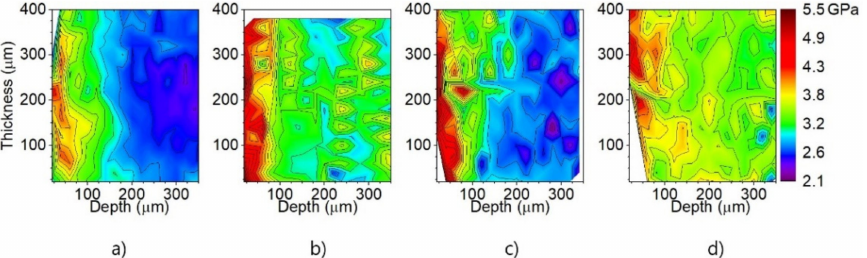
Figure 8. Maps of hardness obtained by means of nanoindentation measurements near the cutting edge before annealing of rings with cutting clearances corresponding to 1% ( a ), 3% ( b ), 5% ( c ), 7% ( d